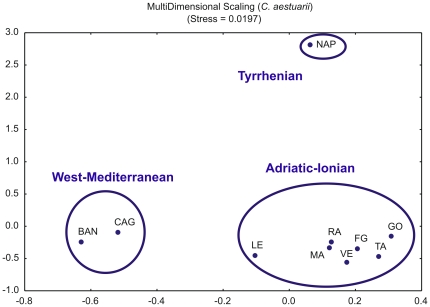
MultiDimensional Scaling analysis (MDS).Plots from MDS analysis for all C. aestuarii locations based on pairwise linearized genetic distance (F
ST/(1- F
ST)) values are shown. Samples are labelled as in Table 1. Groupings have been circled for clarity.